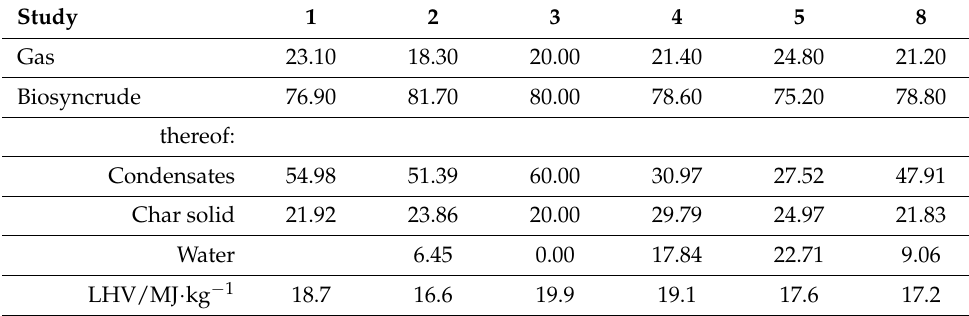
Table 4. Product yields by straw fast pyrolysis (data given in wt.%).